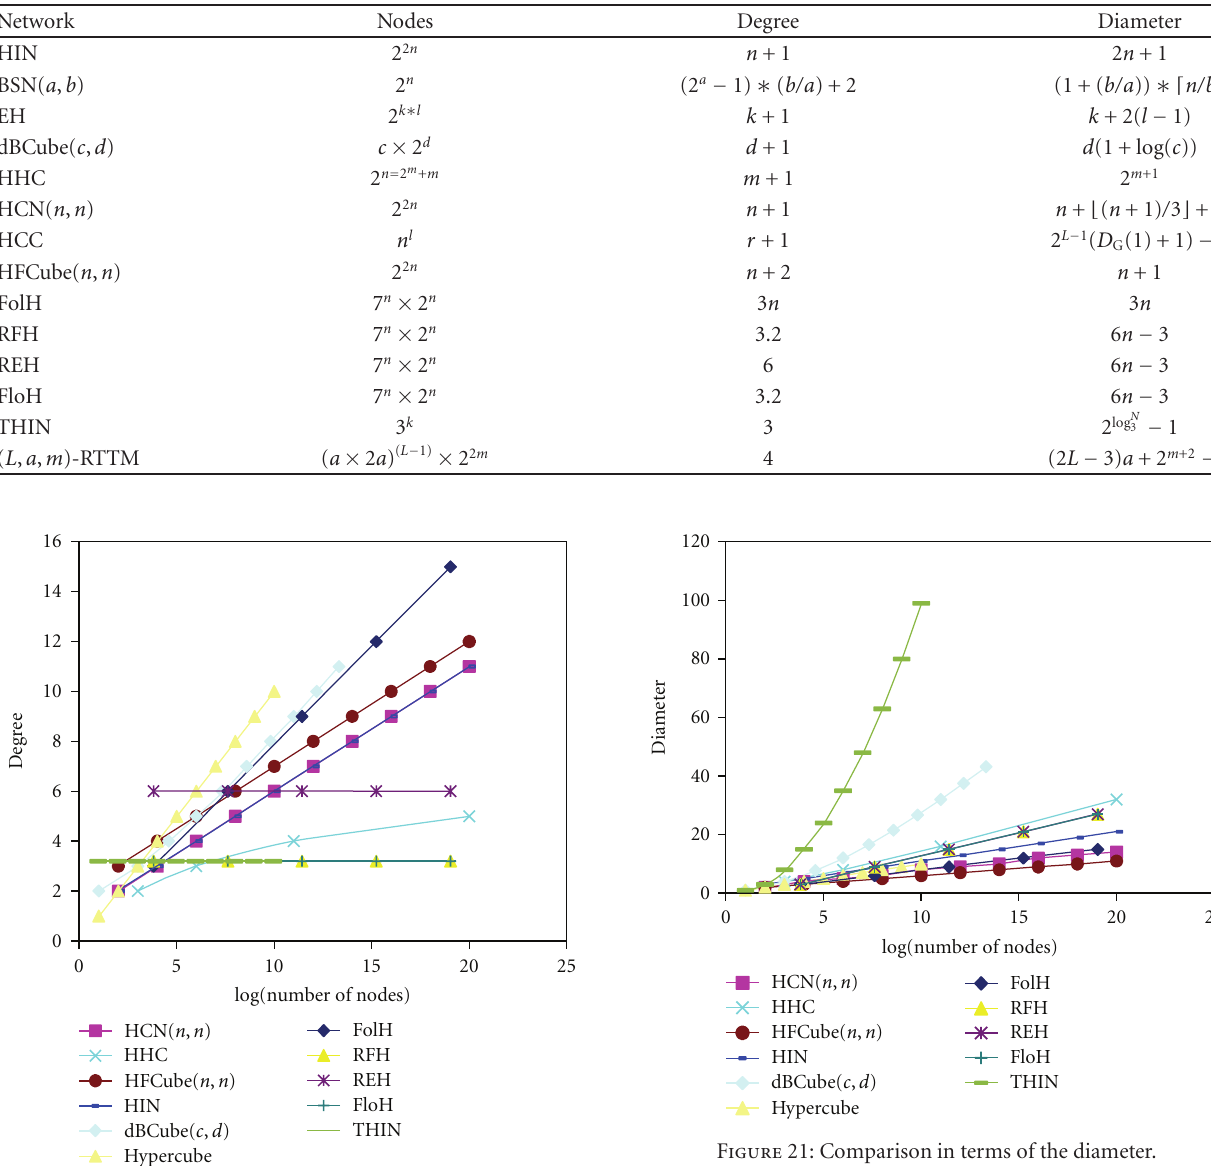
Figure 20: Comparison in terms of the degrees.